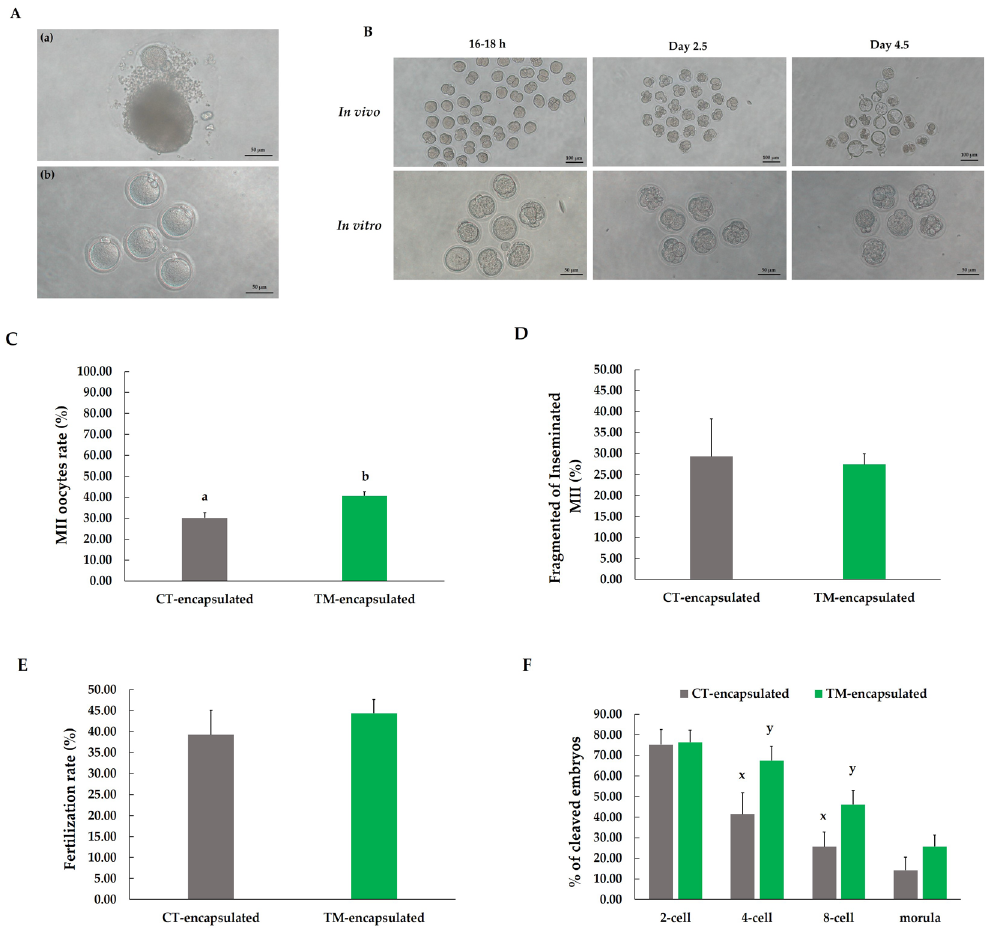
Figure 4. Meiotic and fertilization competence of oocytes from follicles cultured for 12 days in alginate matrix. ( A ) Representative images of follicle after 16–18 h of hCG stimulation (a) and MII oocytes (b). ( B ) Comparison of fertilization and embryo development between in vitro and in vivo mature oocytes. ( C ) Percentage of MII oocytes fertilized by motile sperm obtained through Percoll gradient centrifugation. ( D ) Percentage of fragmented inseminated MII oocytes after IVF. ( E ) Fertilization rate. ( F ) Percentage of cleaved embryo development in different stages. Different letters (a,b) indicate significant differences at p < 0.05, while different superscripts (x,y) tend to differ at 0.05 < p ≤ 0.10 in effects between two groups of follicles. Comparison between groups was performed using chi-squared test. n = 217 antral follicles (grey bars) and n = 280 antral follicles (green bars) for ten replications.